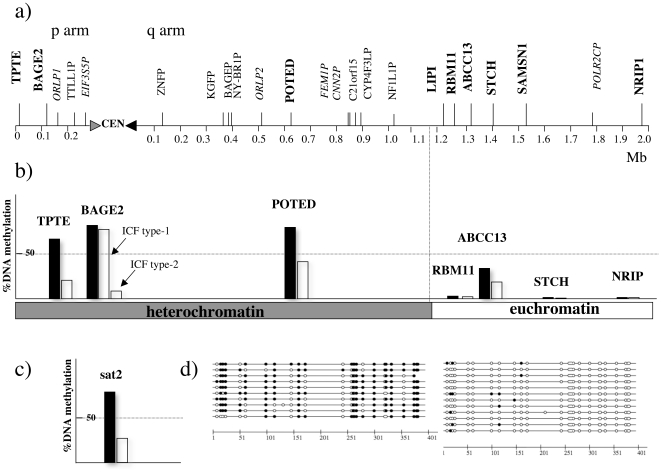
Heterochromatic genes and satellite 2 are hypomethylated in ICF patients.a) Physical map of the 2.3-Mb juxtacentromeric region of human chromosome 21 analyzed in this study. The centromere (cen) is not shown to scale. Genes are bold typed; truncated genes are indicated by plain text and retrotransposed pseudogenes are italicized. b) Histograms represent the percentages of DNA methylation in the analyzed genes either in a pool of controls (black bars) or in a pool of ICF patients (white bars). c) DNA methylation in satellite 2. d) DNA methylation pattern of TPTE, a heterochromatic gene, in a control (left) and an ICF patient (right): full circles are 5mCpG and hollow circles are unmethylated CpG.